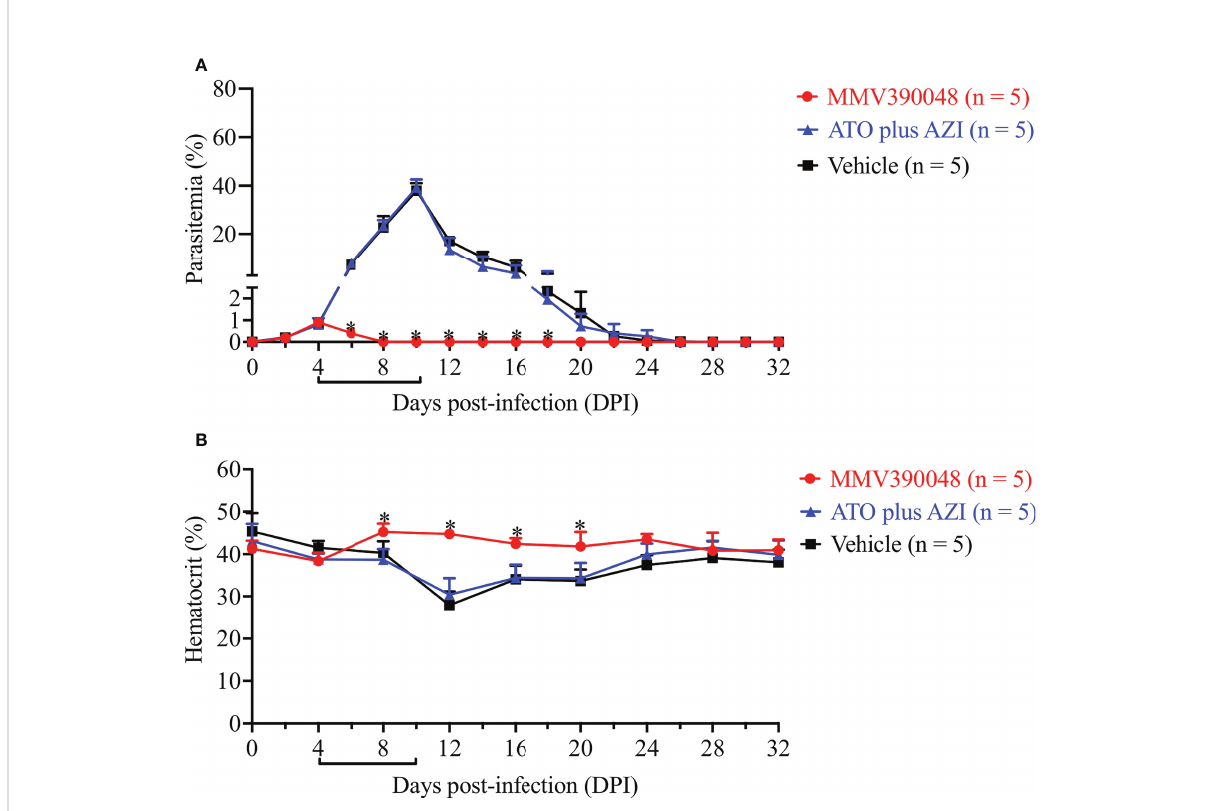
FIGURE 4 The ef fi cacy of MMV390048 against B. microti Cytb mutant strain in BALB/c mice. (A) Course of parasitemia of vehicle- or ATO plus AZI-, or MMV390048-treated BALB/c mouse groups. (B) Hematocrit changes of B. microti Cytb mutant strain in mice treated with vehicle, or ATO plus AZI, or MMV390048. The black lines indicate the time of treatment. The asterisks indicate a signi fi cant difference ( P <0.05) between the drug- treated groups and vehicle-treated group. Parasitemia was calculated by counting infected RBCs among 3,000 RBCs using Giemsa-stained blood